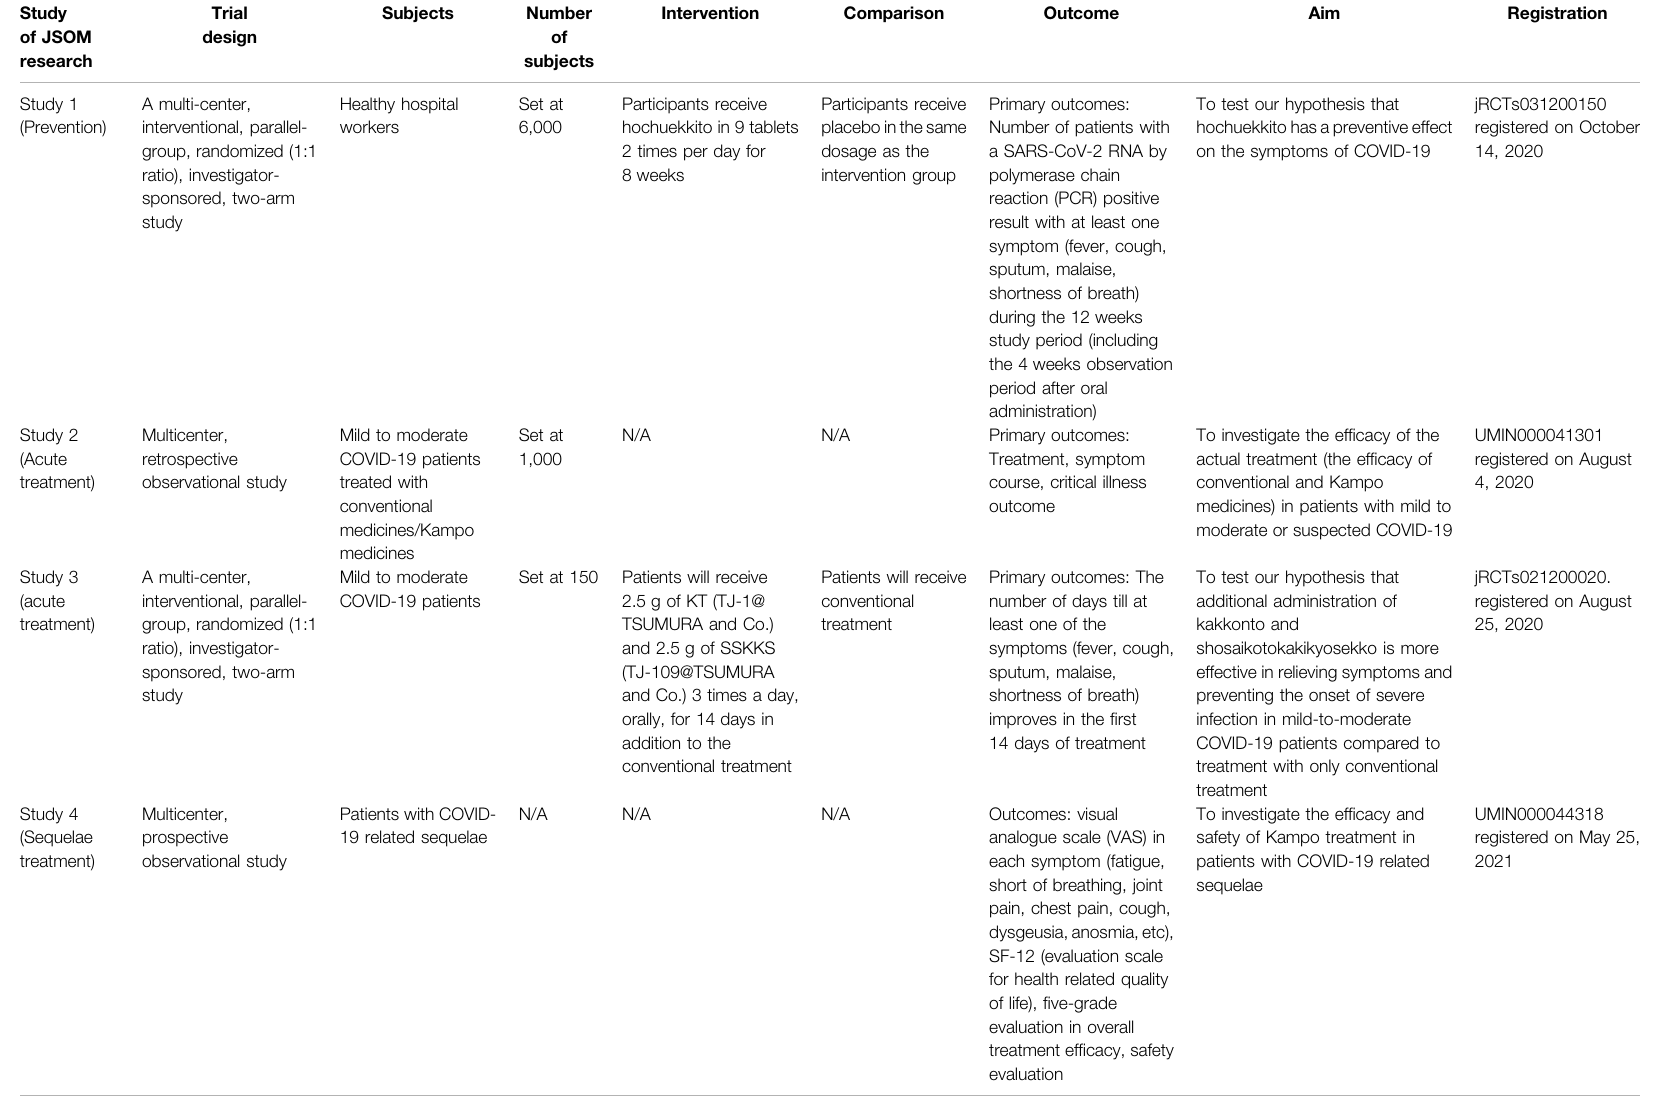
TABLE 3 | Outline of ongoing research on the prevention and treatment for COVID-19 in Kampo